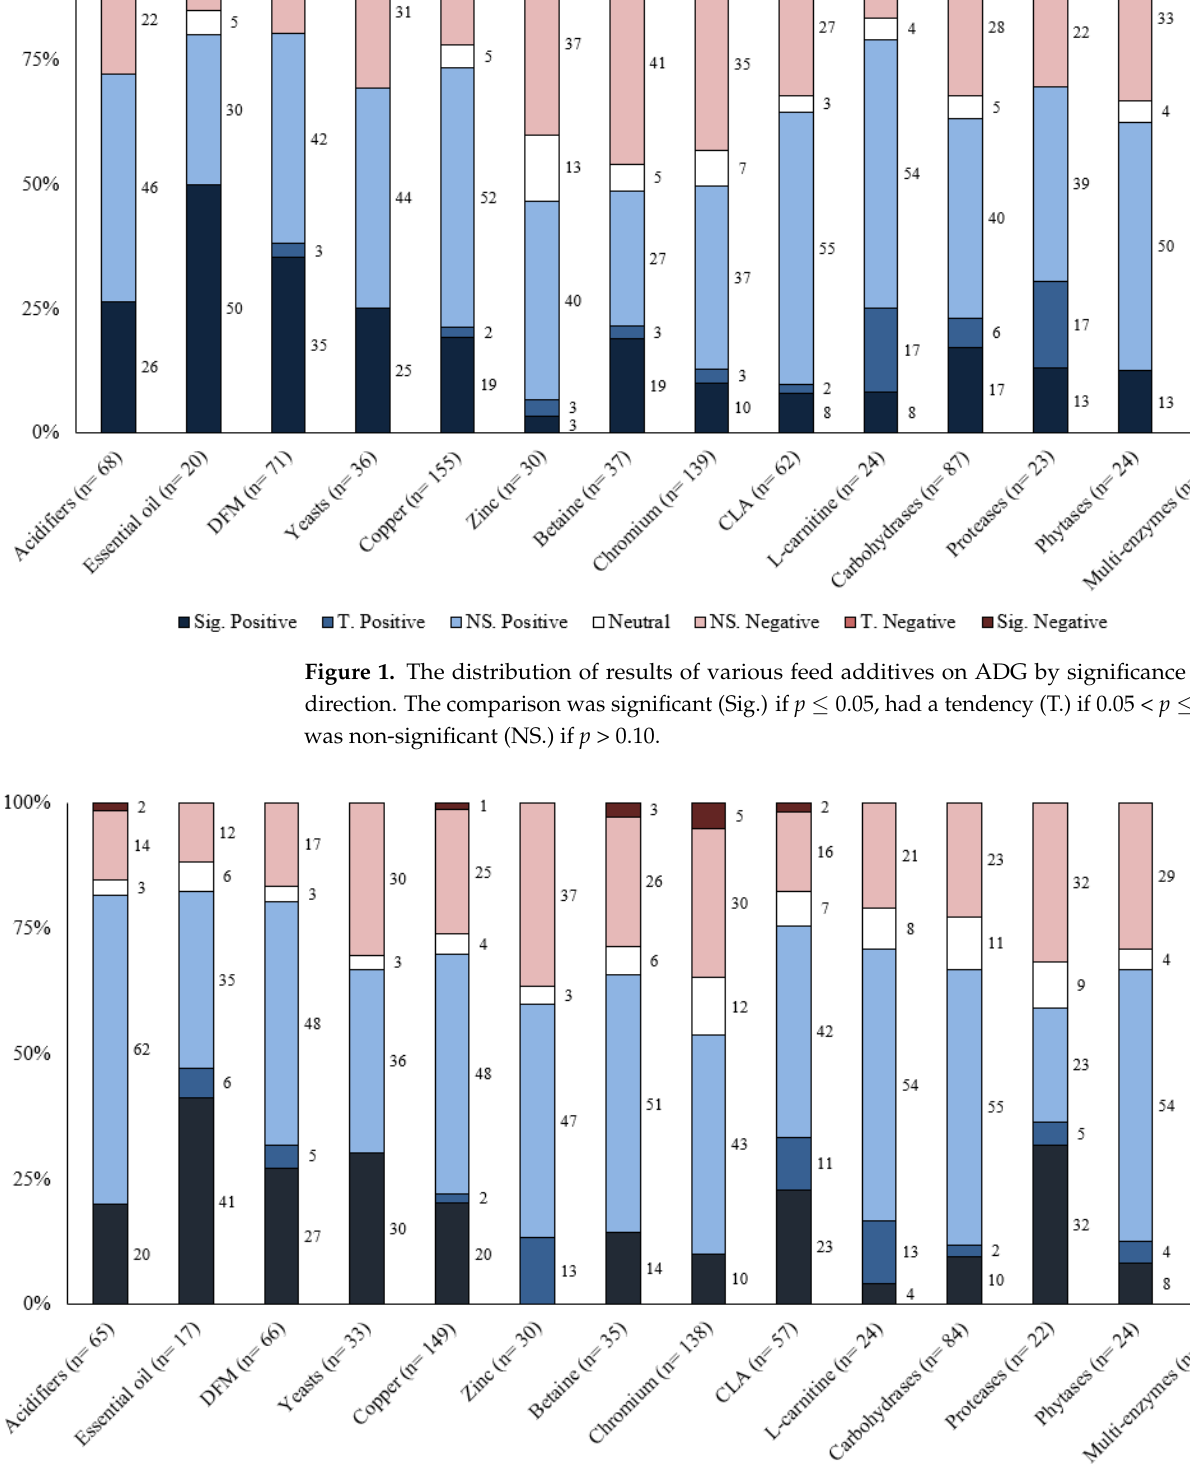
Table 2. Summary of the effects of feed additives on grow–finish pig G:F 1,3 .